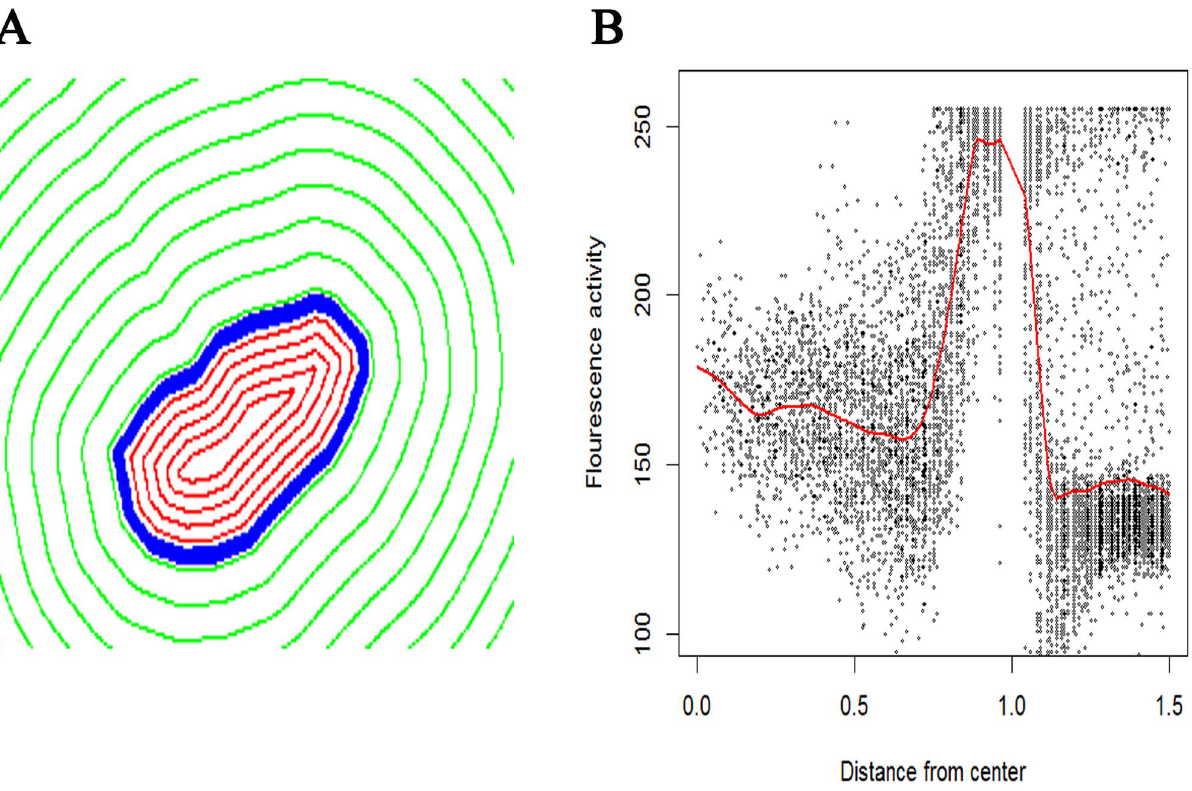
Figure 2. Radial distance map of a cell. A) Blue line shows cell boundary (radial distance=1). Red line show contours of equal radial distance within the cell (radial distance , 1). Green lines show contours of equal radial distance outside the cell (radial distance . 1). B) Plot of the distribution of PLC d 1-GFP expression as a function of distance from center of the cell. The red line shows the average activity as a function of distance, obtained via a smoothing line. The x-axis (radial distance) is truncated at 1.5 to avoid contamination of PLC d 1-GFP expression from other cells.